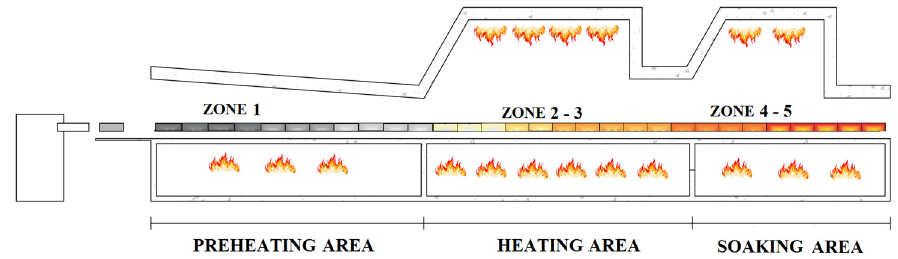
Figure 2. Schematic representation of a steel industry billets reheating